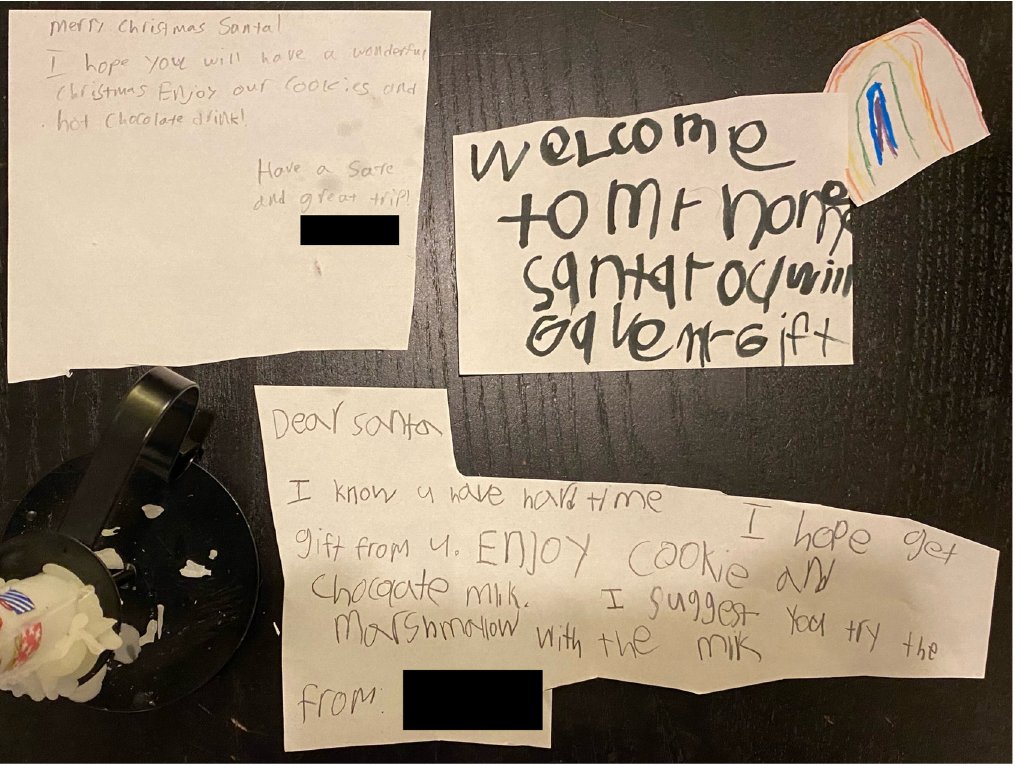
Figure 1. Three deaf siblings’ letters to Santa.